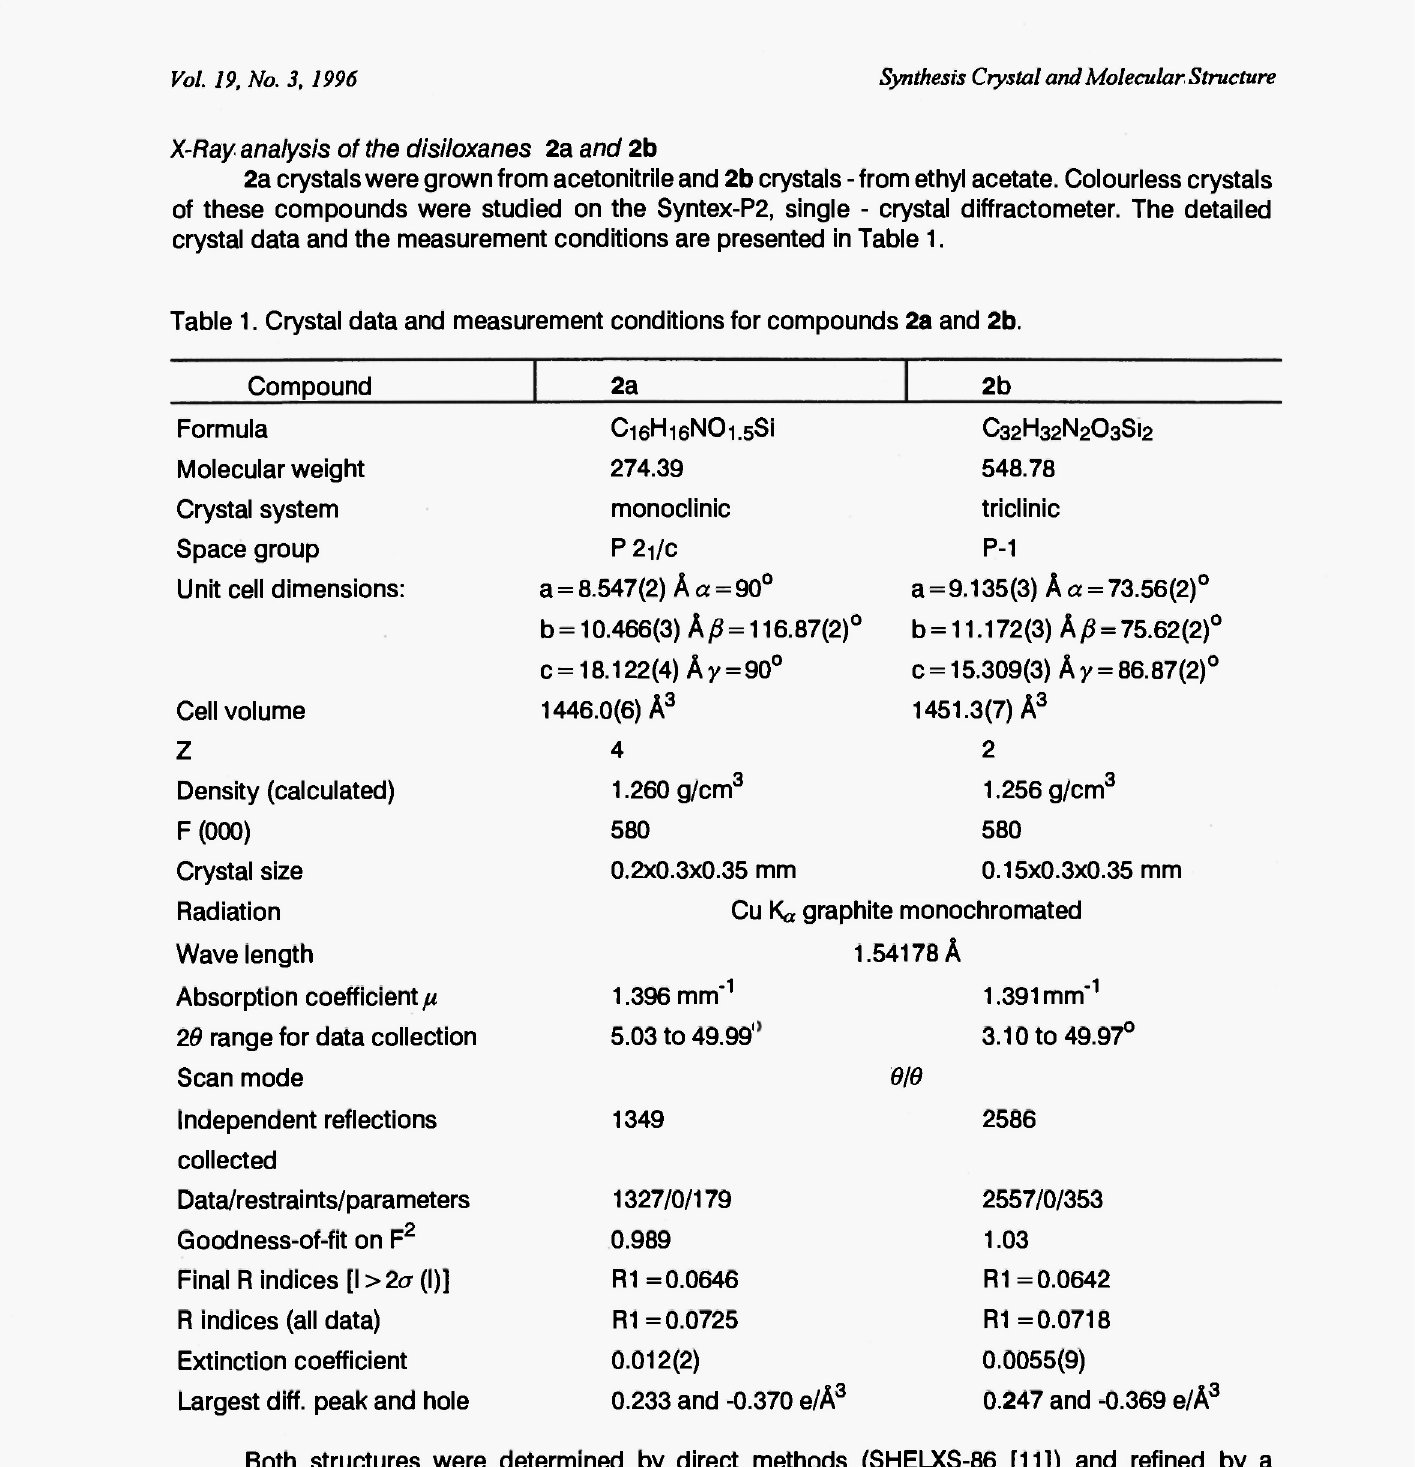
Table 1. Crystal data and measurement conditions for compounds 2a and